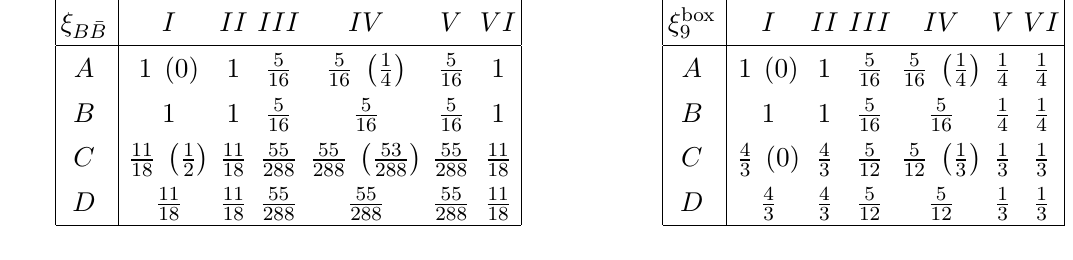
for the case equal masses. The number in 9